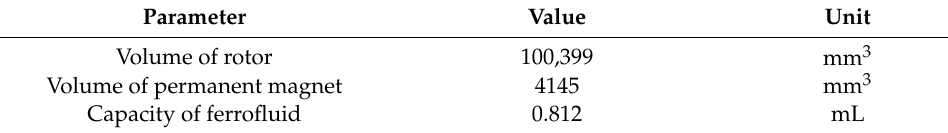
Figure 21. Process of setting up the experimental equipment. Table 4. Capacity of ferrofluid used to make the final model.